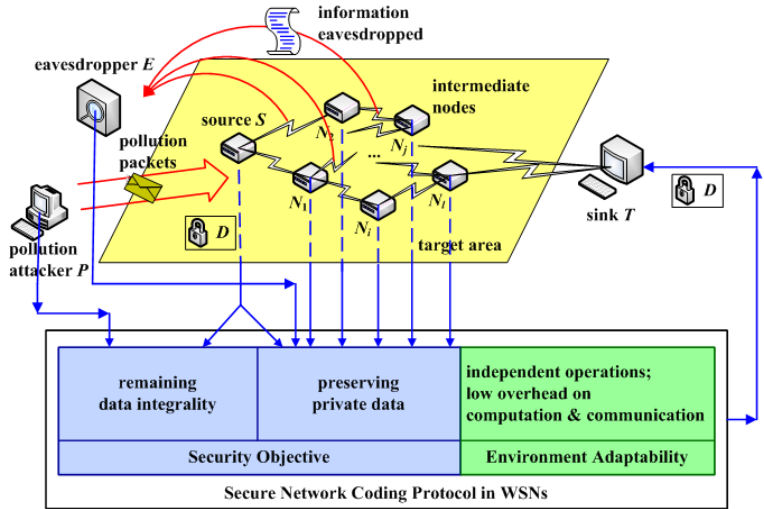
Fig. 1. Formalized model